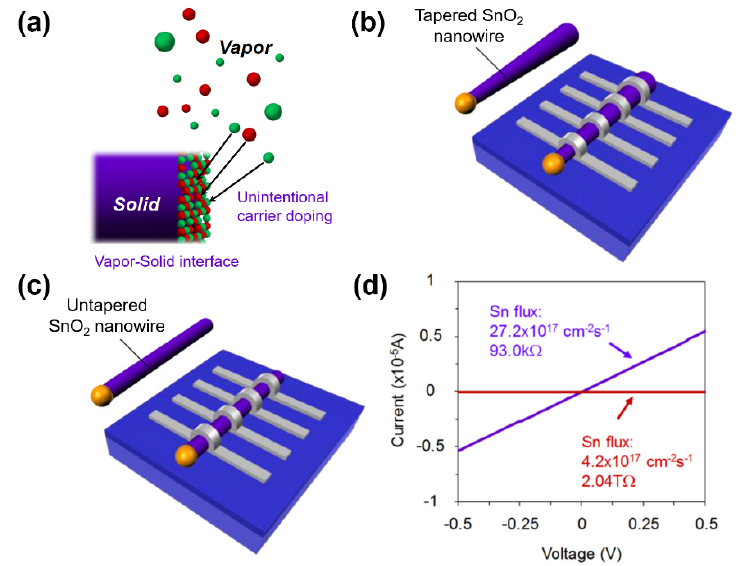
Figure 5. Anomalous electrical properties of VS growth nanowire: ( a ) a schematic image of uninten- tional carrier doping occurs at the vapor–solid interface during VS growth; ( b ) single tapered VS+VLS growth SnO 2 nanowire device; ( c ) single untapered VLS growth SnO 2 nanowire device; ( d ) IV curves of VS growth (93.0 k Ω ) and VLS growth nanowire (2.04 T Ω ); Reprinted from reference [79] with permission from the American Chemical Society.